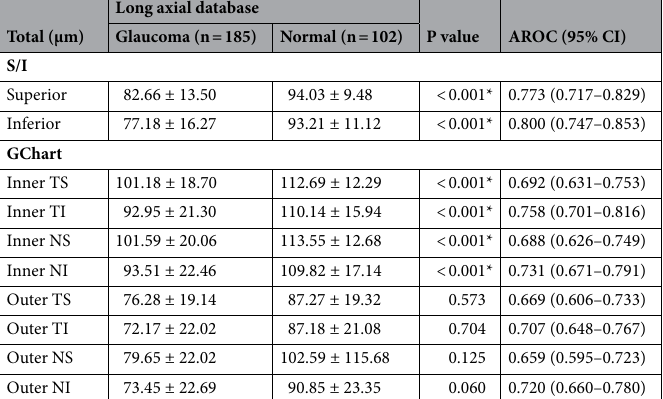
Long axial Total (µm)